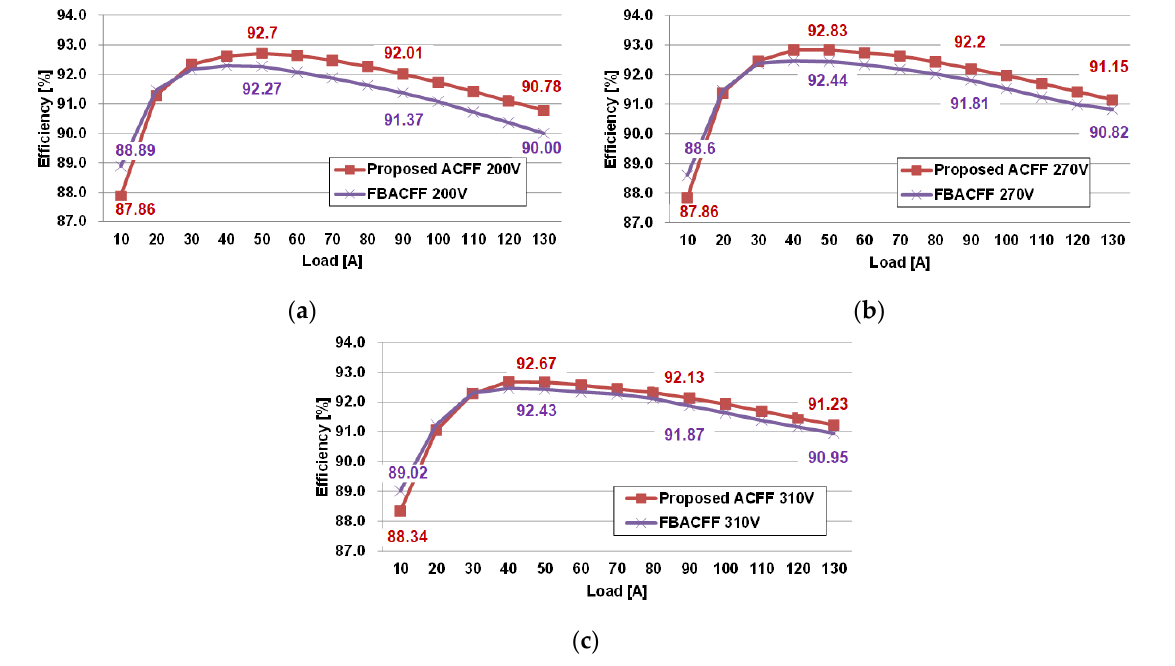
Figure 18. Measured efficiency according to input voltage: ( a ) Minimum input ( V S = 200 V). ( b ) Nominal input ( V S = 270 V). ( c ) Maximum input ( V S = 310 V).